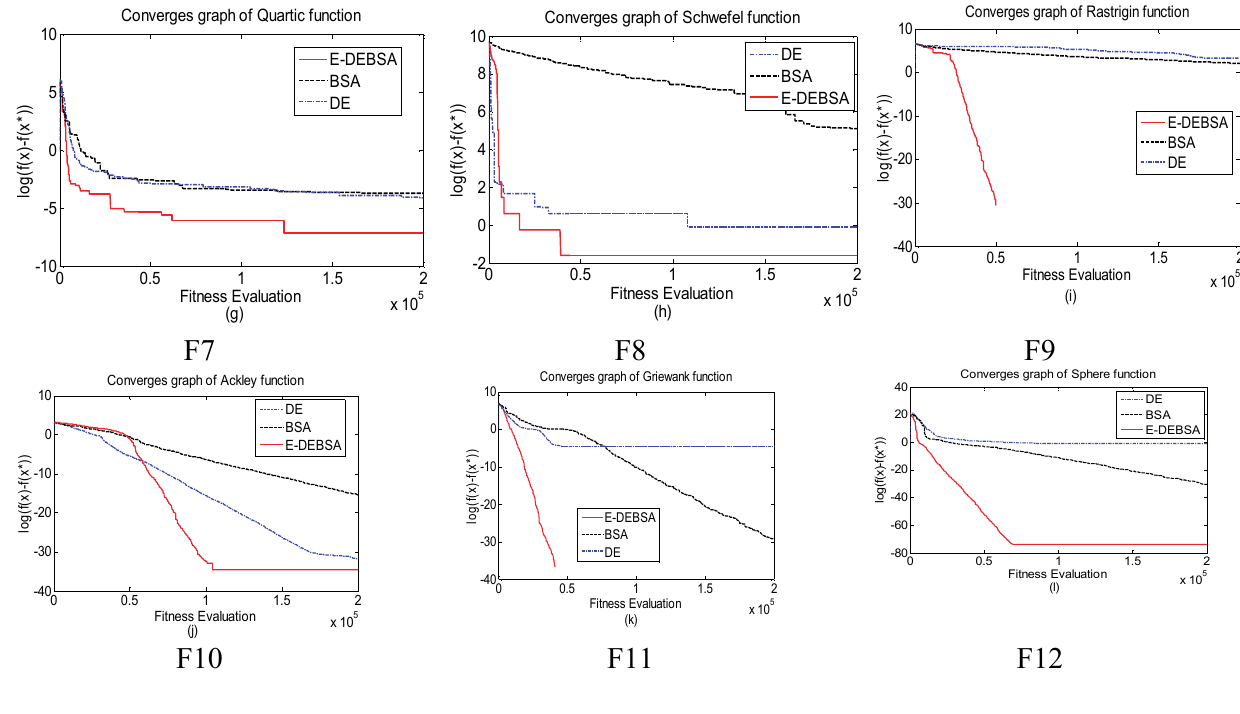
Fig. 1. Convergence curves of 50 dimensional test functions: (a) F1, (b) F2, (c) F3, (d) F4, (e) F5, (f) F6, (g) F7, (h) F8, (i) F9 , (j) F10 , (k) F11 , and (l) F12